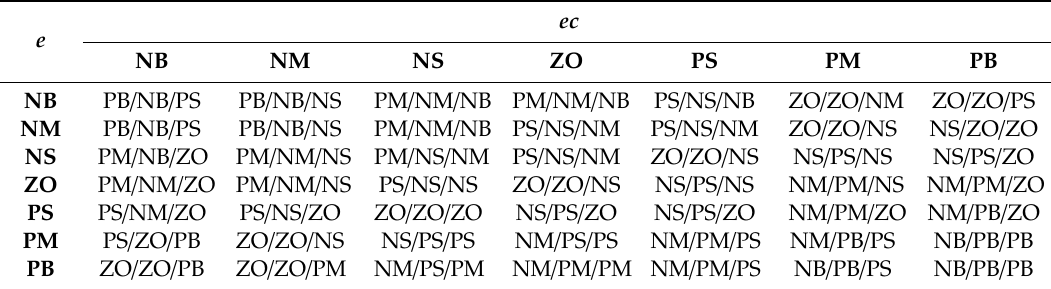
Table 4. ∆ K p , ∆ K i and ∆ K d fuzzy control